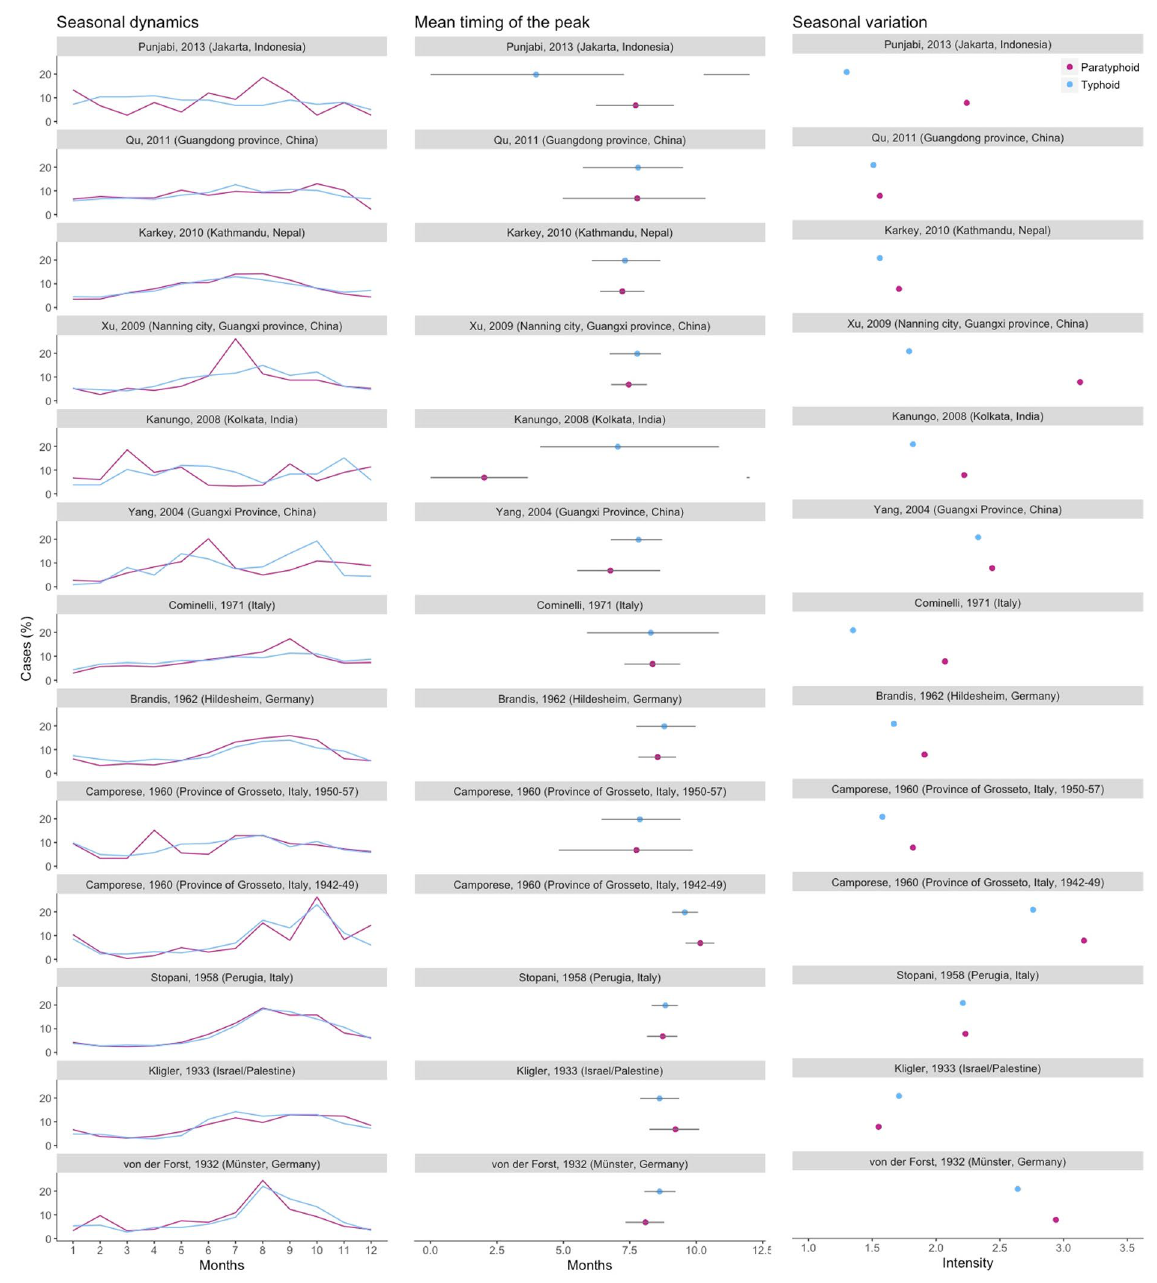
Figure 5. Seasonal dynamics, mean timing of the peak and seasonal variation for studies with typhoid and paratyphoid data. On the left, the percent of annual cases occurring in each month are plotted for paratyphoid fever (purple) and typhoid fever (blue). In the middle, mean timing (as defined by center of gravity) is represented by the dots, while the line corresponds to the 95% confidence interval. On the right, the seasonal variation (peak/mean) is